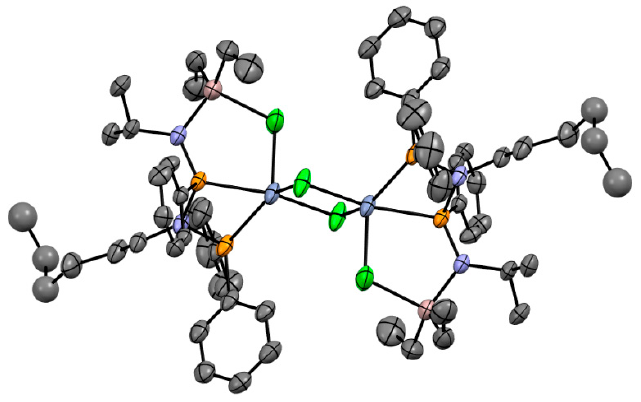
Figure 31. Molecular structure of complex Cr12